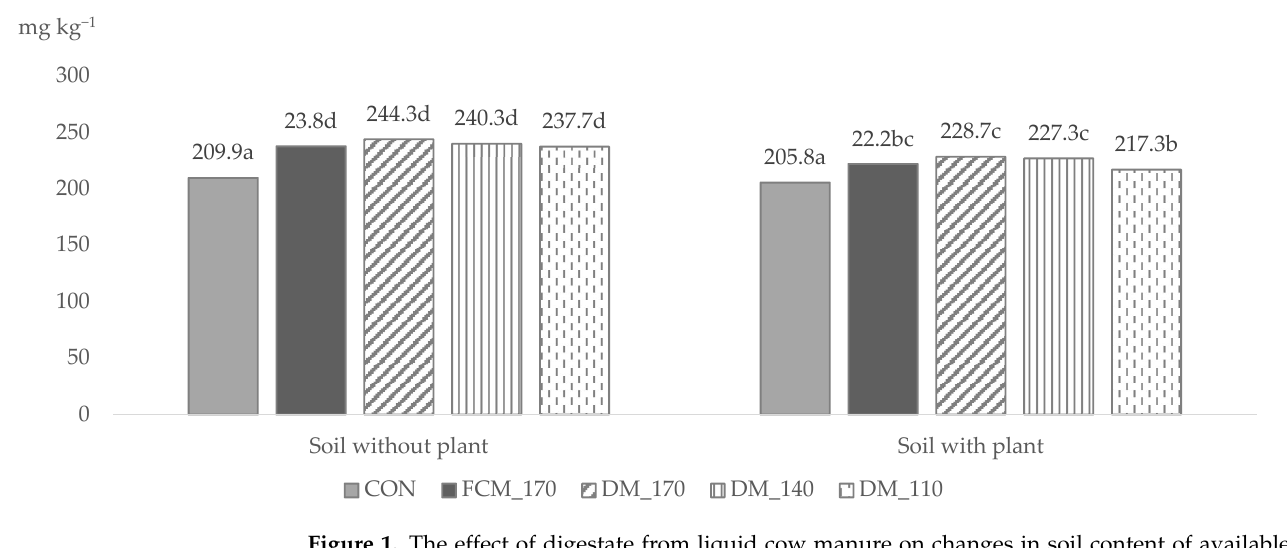
Figure 1. The effect of digestate from liquid cow manure on changes in soil content of available